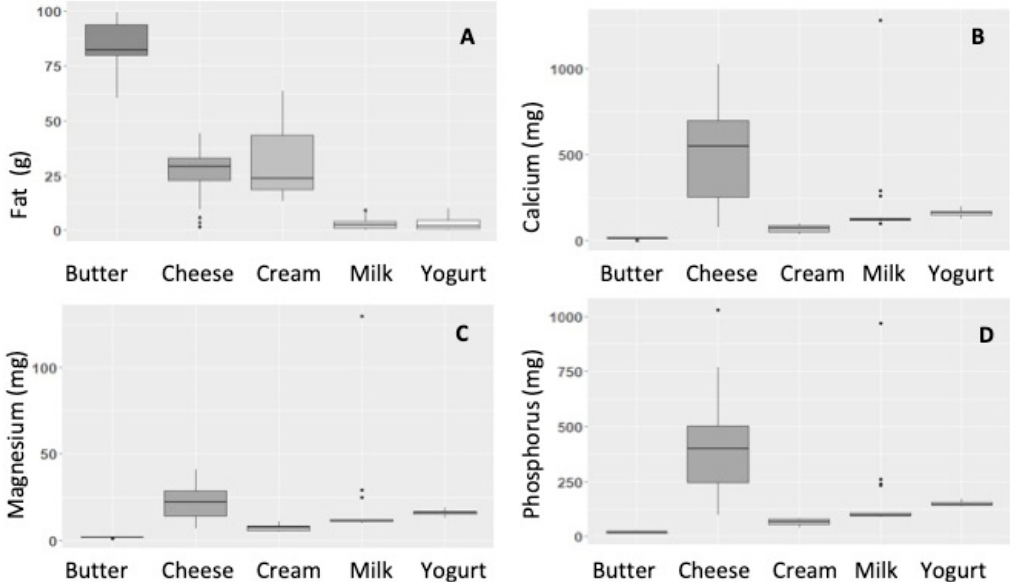
Figure 2. Boxplot showing average fat and mineral content in dairy products per 100 g. Values from the Composition of Foods Integrated Dataset (CoFID). Only plain, unflavoured products with no added sugar were included in this analysis. Nutrients shown are: ( A ) total fat (g), ( B ) calcium (mg), ( C ) magnesium (mg) and ( D ) phosphorus (mg), calculated from n = 4 butter, n = 43 cheese, n = 8 cream, n = 20 milk and n = 4 yoghurt samples.